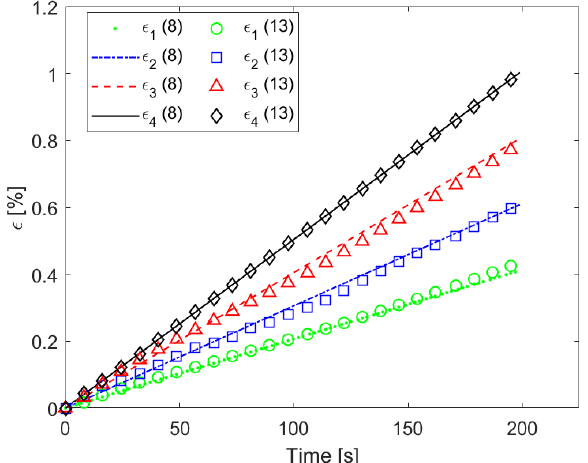
Figure 15. Strain vs. time at four different points ( x 1 , x 2 , x 3 , x 4 ) of Figure 5 during the three-point bending test obtained either by using Equation (8) (that is, knowing the position of the sensors, the beam geometry and the crosshead deflection vs. time) or by using Equation (13) (that is, from the measurements of the variation in resistance of the sensors and the piezoresistive sensitivity).